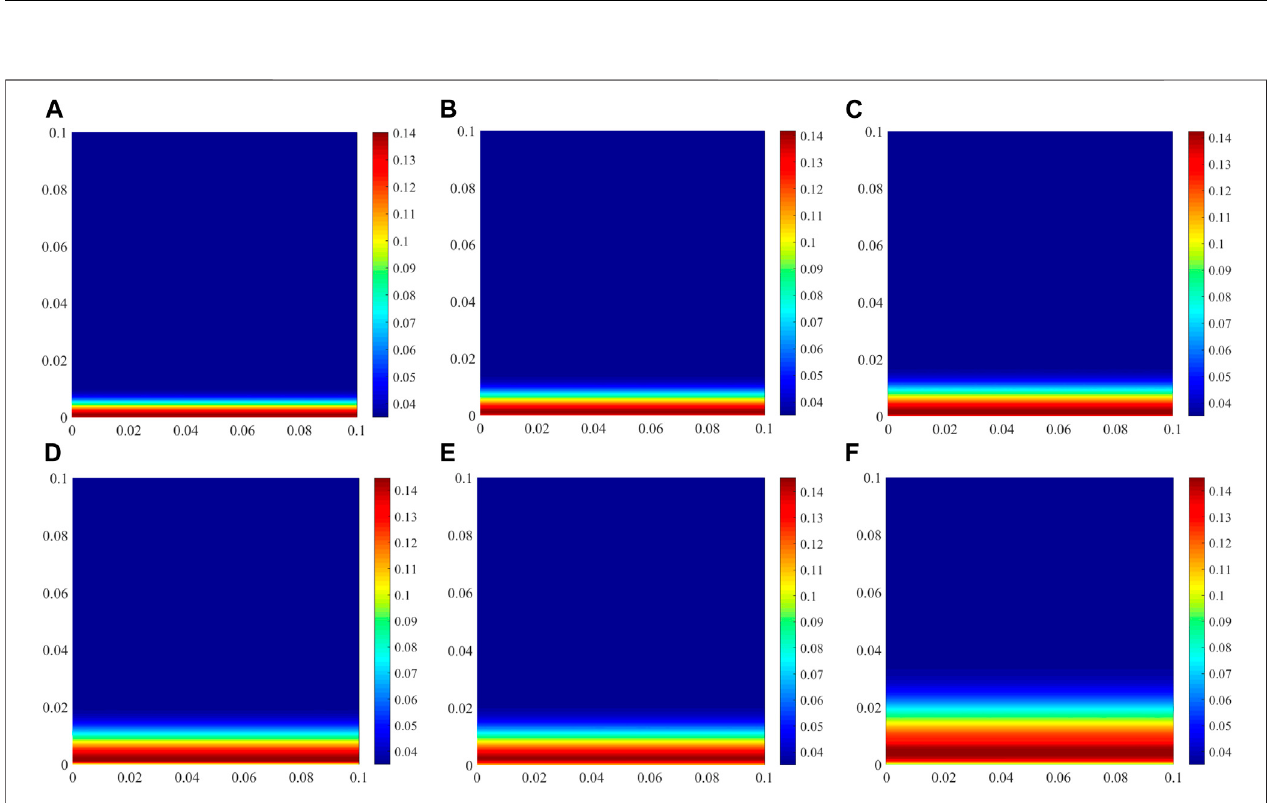
FIGURE 6 | Physically bound chloride by C − S − H at different exposure times (unit: mol/L of concrete). (A) 30 days, (B) 60 days, (C) 90 days, (D) 120 days, (E) 180 days, (F) 360 days.